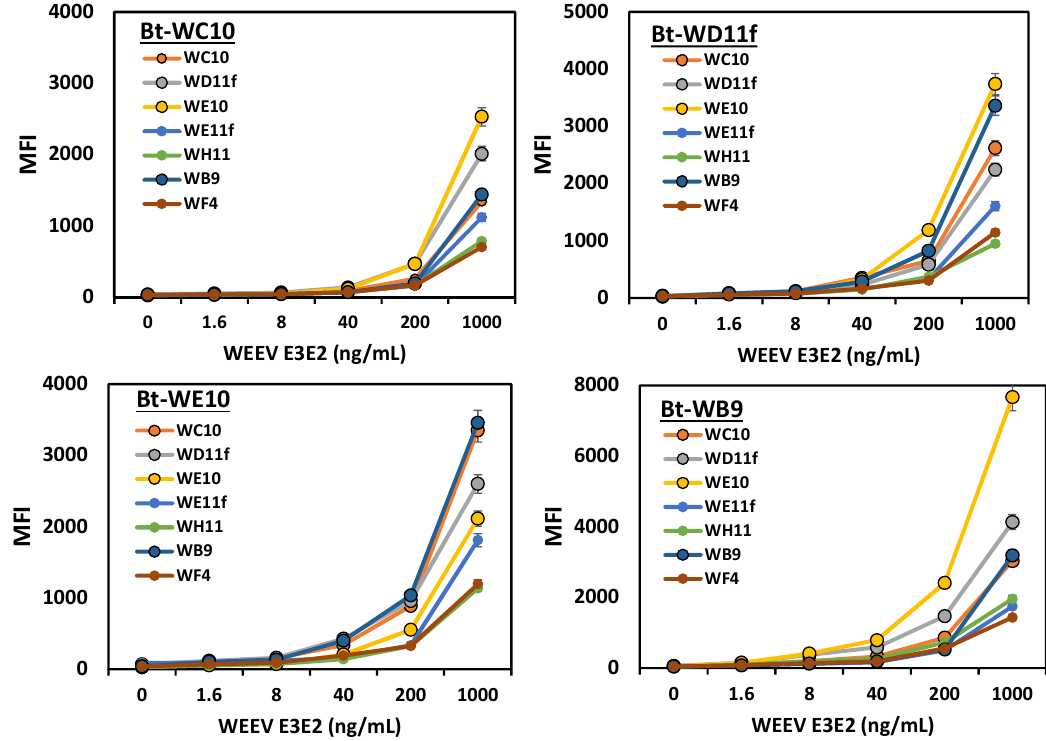
Figure 3. MagPlex sandwich fluoroimmunoassay to evaluate the utility of the sdAb to function as both a capture and recognition reagent for the detection of WEEV E3E2 protein. Only the four best Bt-sdAb recognition reagents are shown. Median fluorescence intensity versus WEEV E3E2 concentration is plotted; error bars represent the SEM.